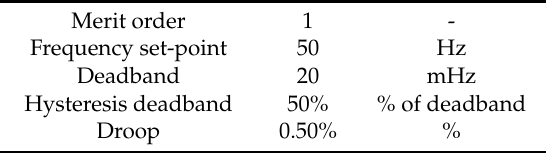
Table 6. FCR service configuration in the EESS of Table 5.